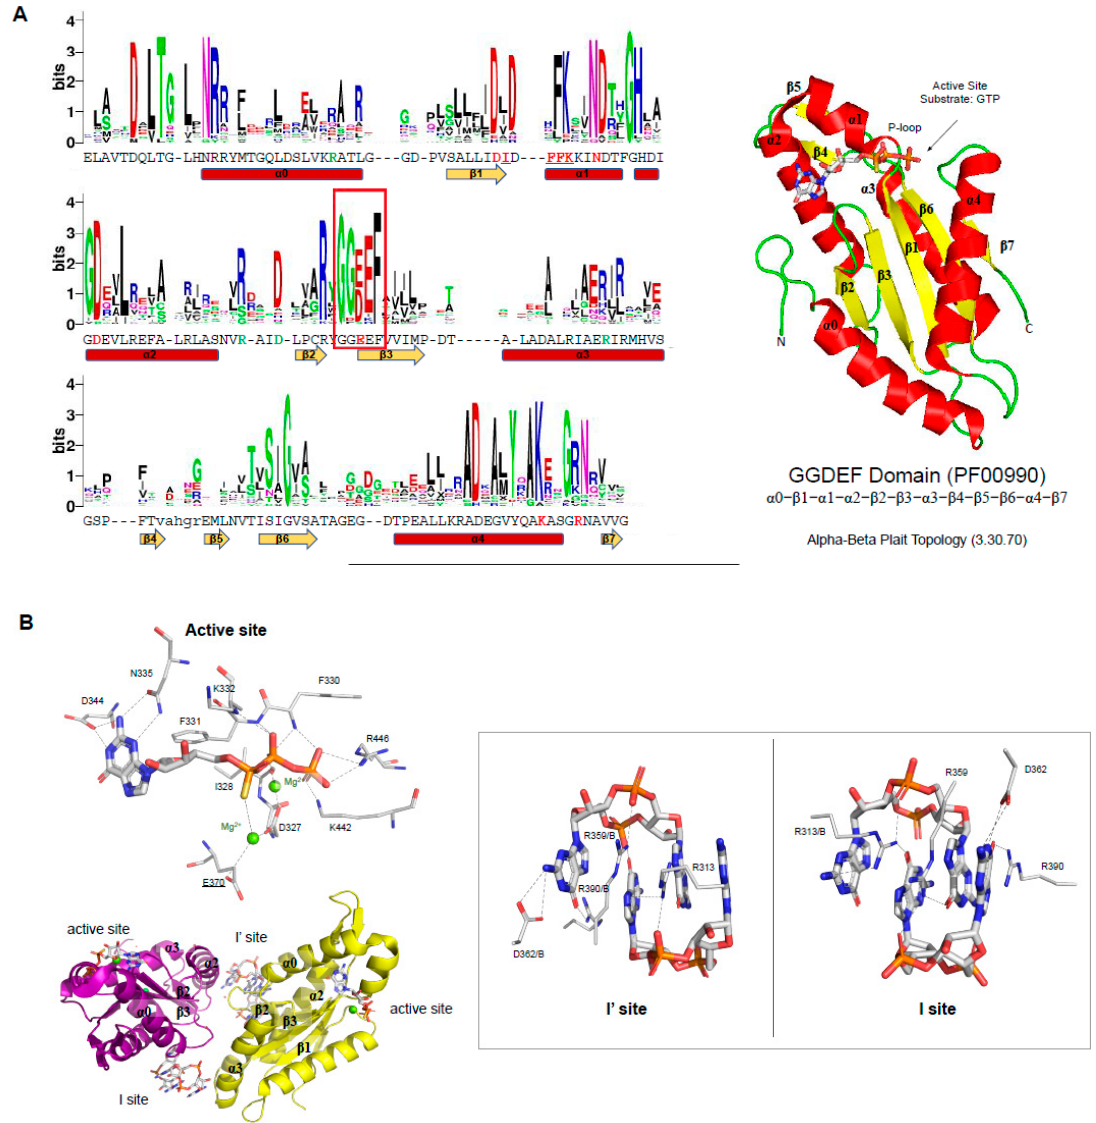
Figure 3 . Conserved sequences within GGDEF members and their active and I-sites pockets. ( A ) residue frequency in GGDEF domains. Using the Dali server [79] , 23 sequences of GGDEF domain structures were used to create a multiple sequence alignment, and the sequence logo was created with the WebLogo server [90]. The sequence shown below the logo and the secondary structure elements belong to PleD of Caulobacter vibrioides (PDBID: 2V0N). Residues colored in red are involved in ligand or magnesium binding (for underlined residues, only the main chain is involved) and those colored in green are located in the I-sites. The GGDEF motif is placed in a red box. On the right, the structure of the GGDEF domain of PleD is shown as a cartoon. The topology of GGDEF is shown below the structure, and the CATH topology name and code are also shown [91]; ( B ) interaction network between the GGDEF domain of PleD binding pocket with the substrate, GTP. In the bottom, the PleD structure in the inactive conformation is shown, in which the two inhibitory sites are shown (I-site and I’-site). On the right, it is shown in more detail the residues involved in the (c-di-GMP) 2 interactions at the inhibitory sites. Gray dotted lines represent hydrogen bonds. The magnesium ions are colored in green. GTP and the protein residues involved in its binding are shown as sticks. Carbons are colored white, oxygens are red, nitrogen atoms are blue, and phosphorous atoms are orange.